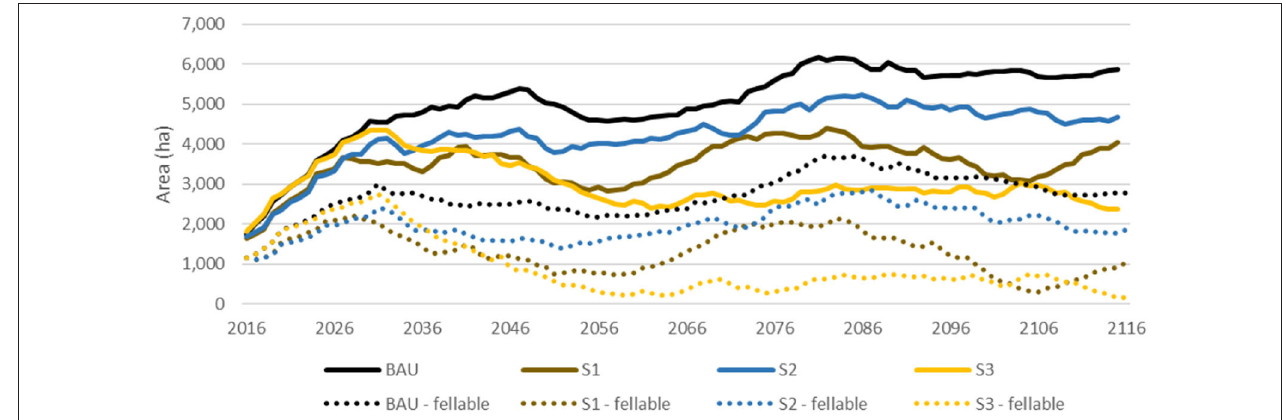
FIGURE 5 | Forest area (solid) and fellable forest area (dashed) with a critical windthrow risk over 70%, for the BAU, S1, S2, and S3 scenarios.